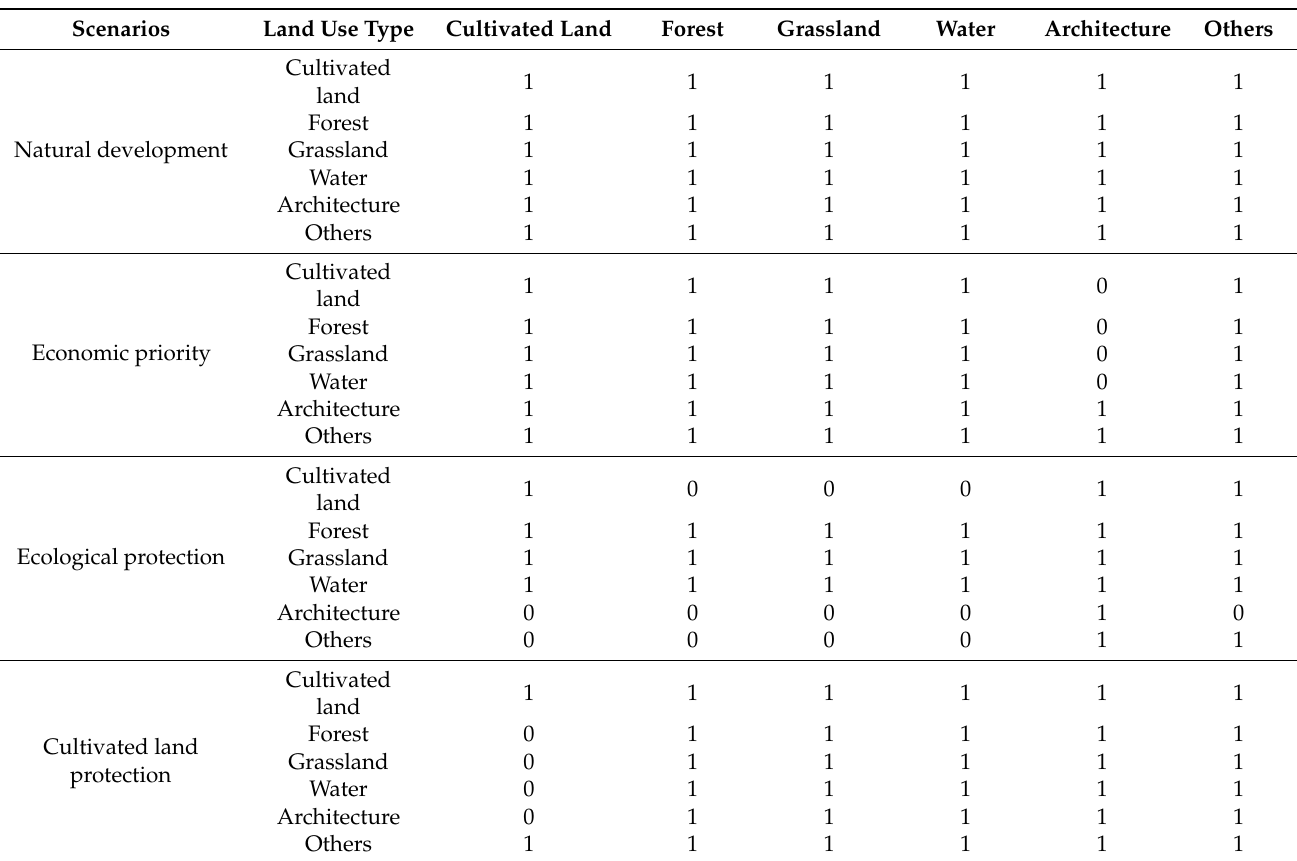
Table 5. Conversion cost coefficients between land use